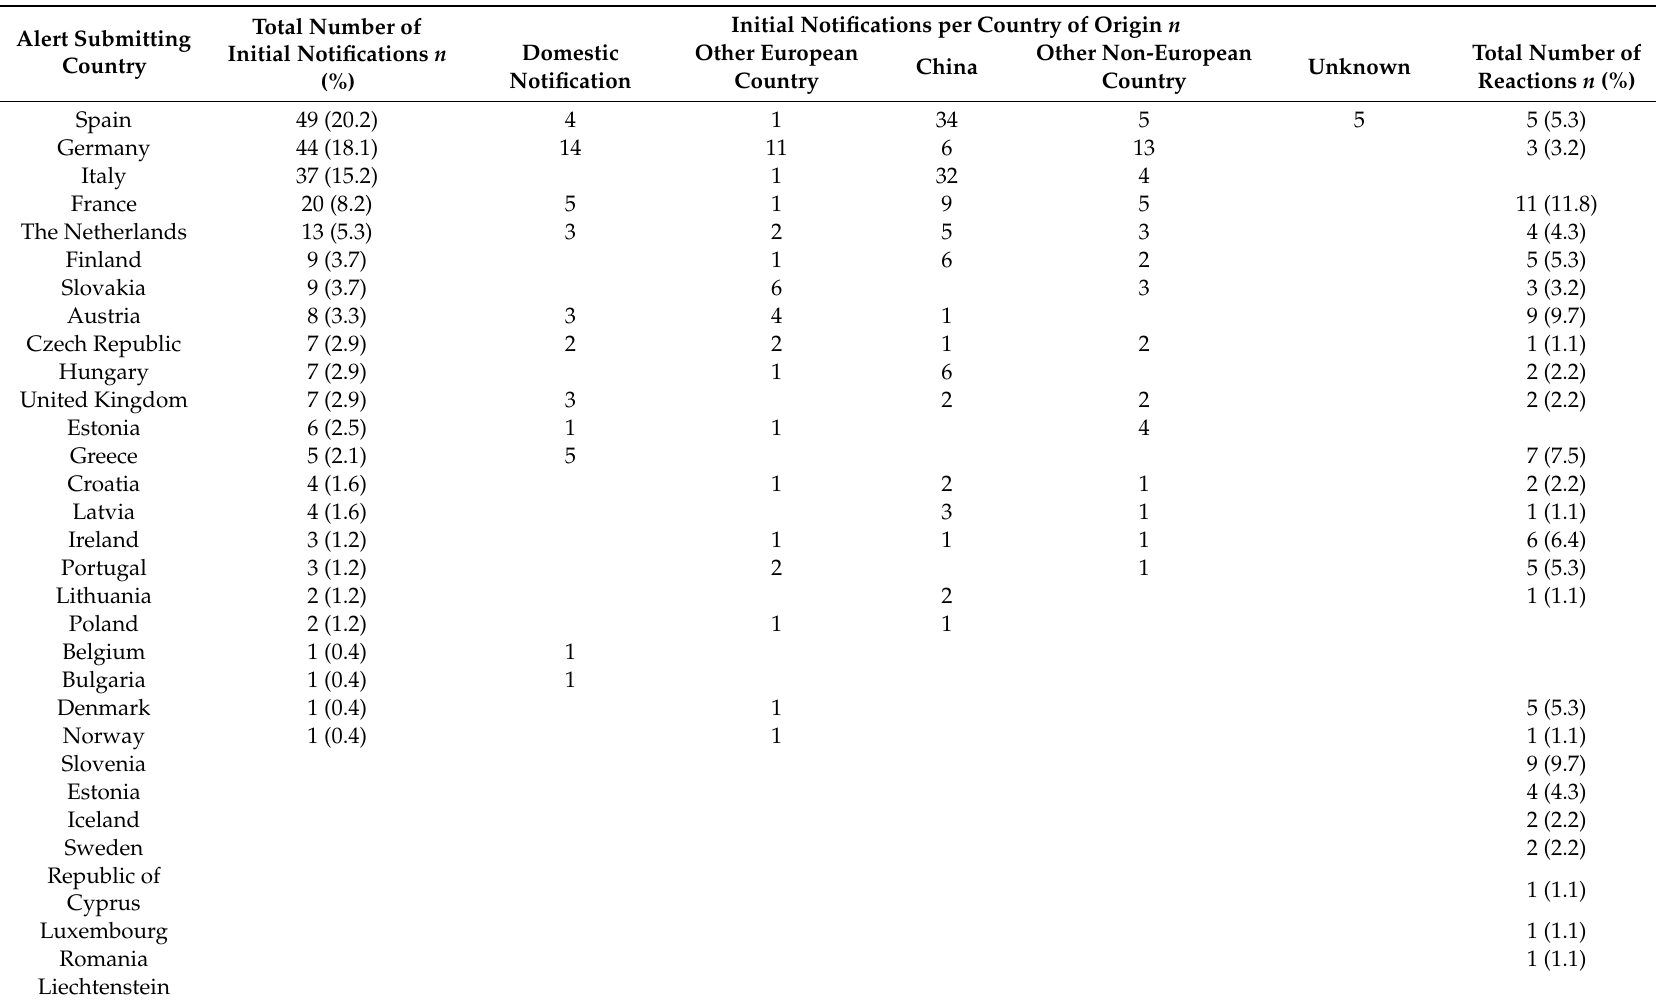
Table 2. Number of initial notifications and reactions for products posing a microbiological risk (2005–2017) listed for each country. The manufacturing country named in the initial notification is given (domestic, other European Union (EU) and European Economic Area (EEA) member states (MS), China, and other non-EU